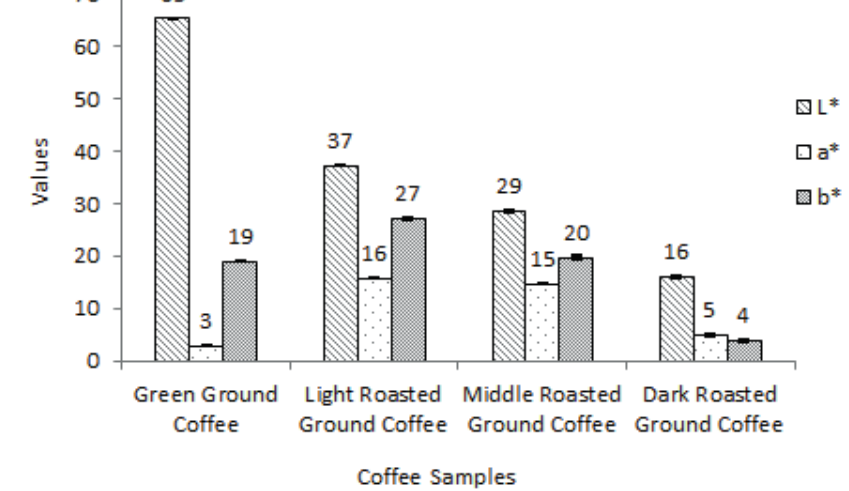
Figure 1 - L*, a* and b* values for Arabica ground coffee samples at different roast